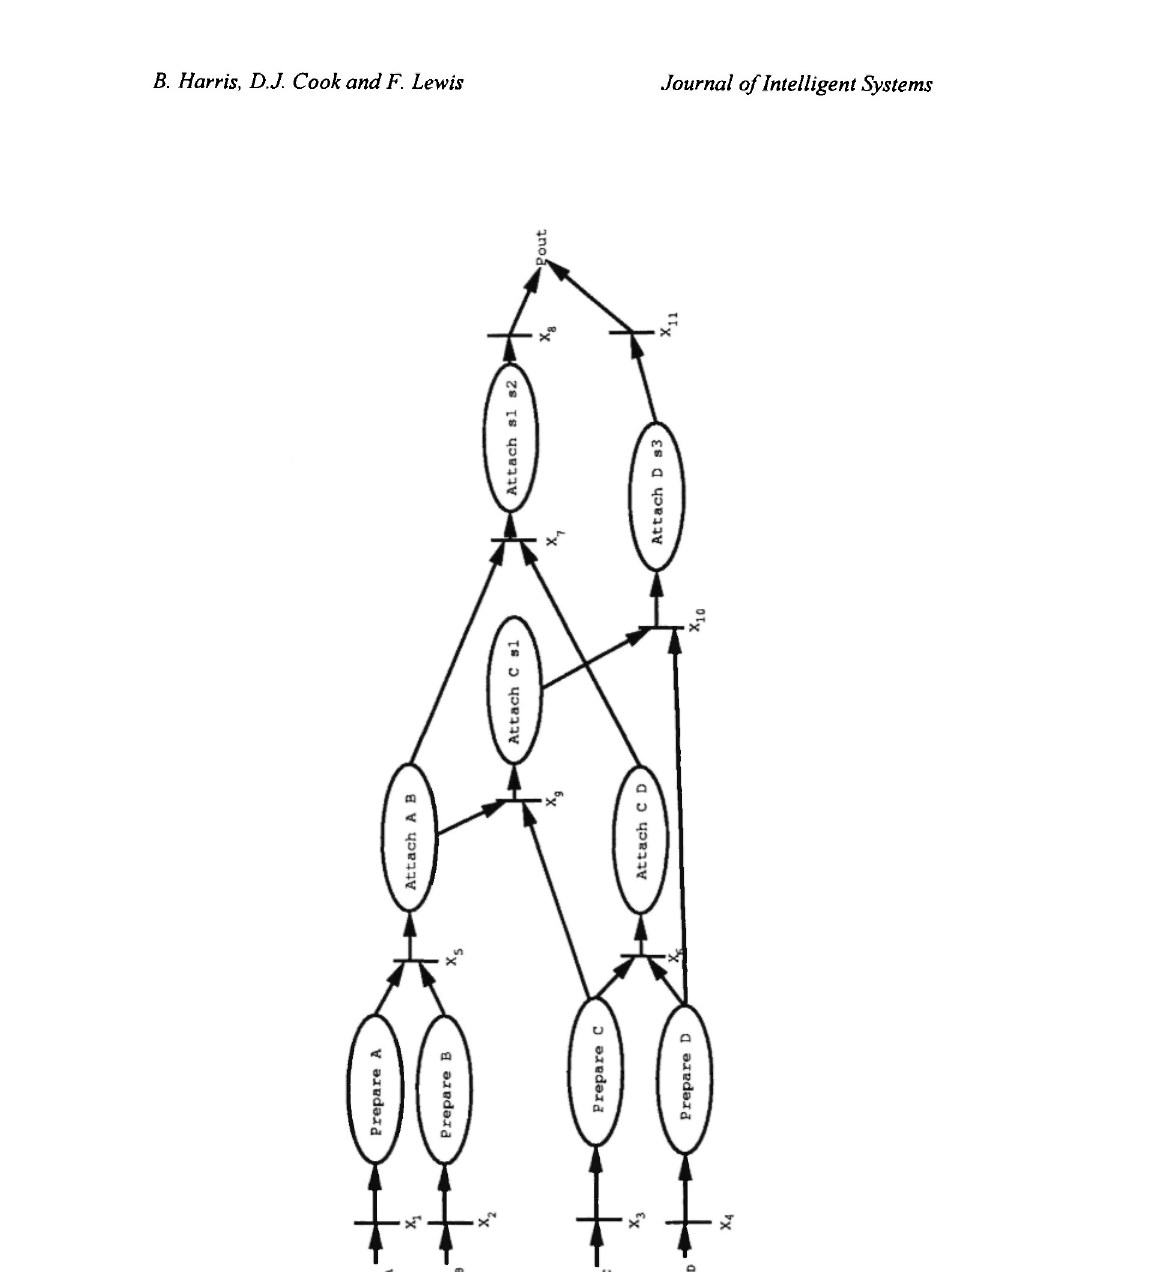
Fig. 29: Combined Petri